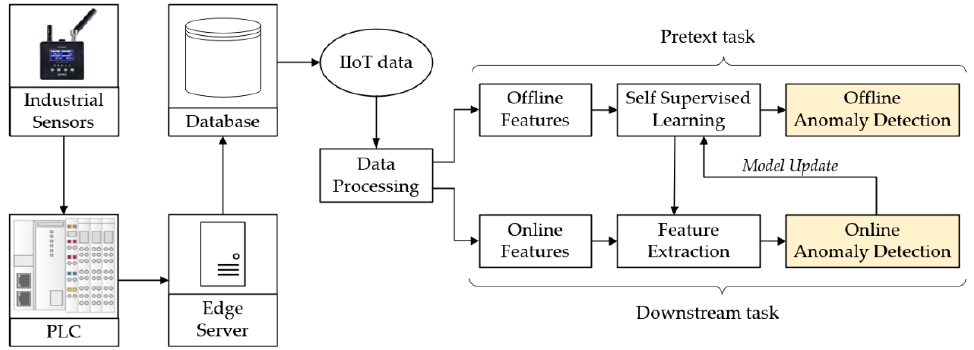
Figure 1. Anomaly detection framework in IIoT system using the SSL method.